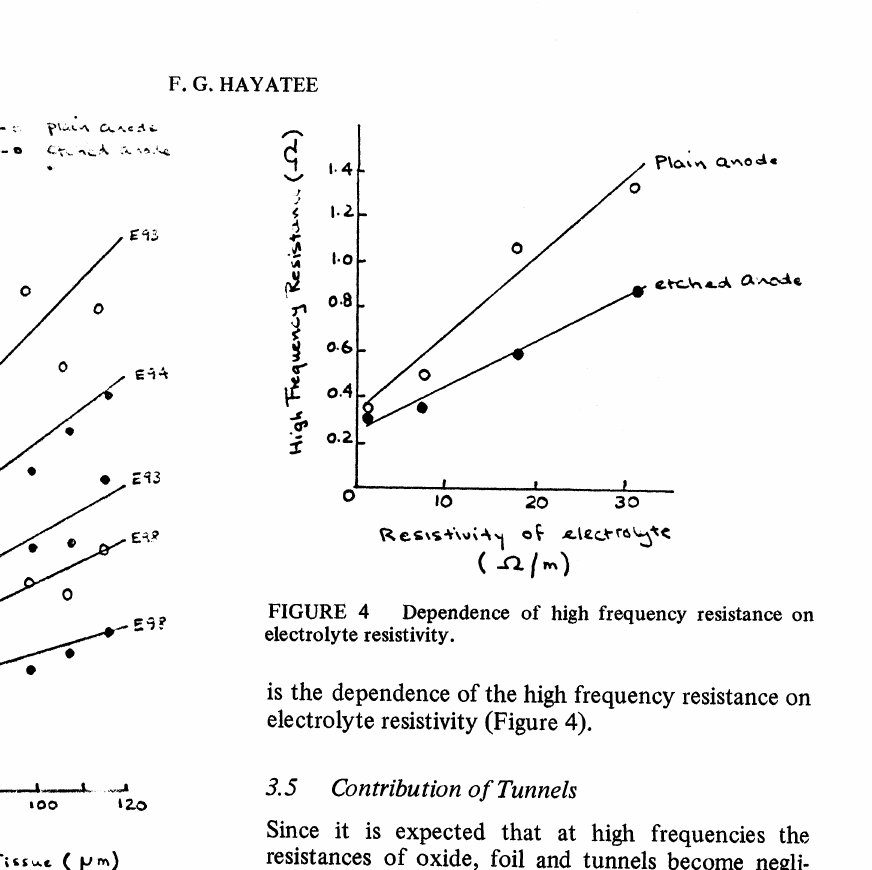
FIGURE 4 Dependence of high frequency resistance on electrolyte resistivity. is the dependence of the high frequency resistance on electrolyte resistivity (Figure 4).